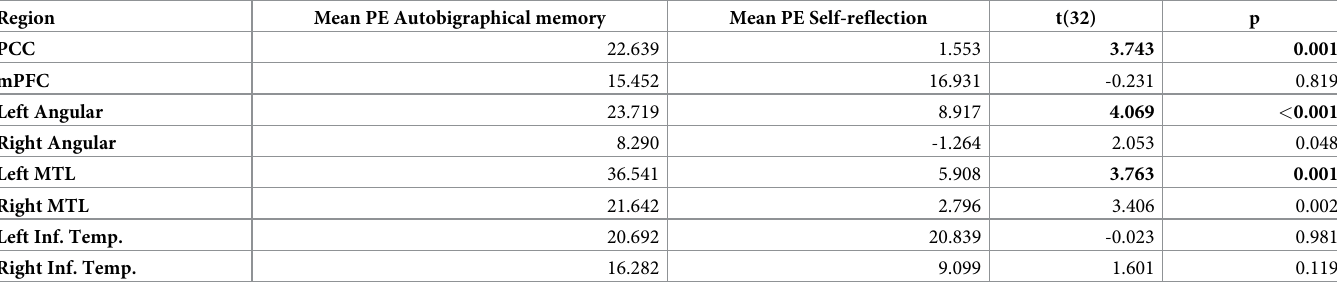
Table 6. Comparison between activation levels in autobiographical memory and self-reflection conditions. Region